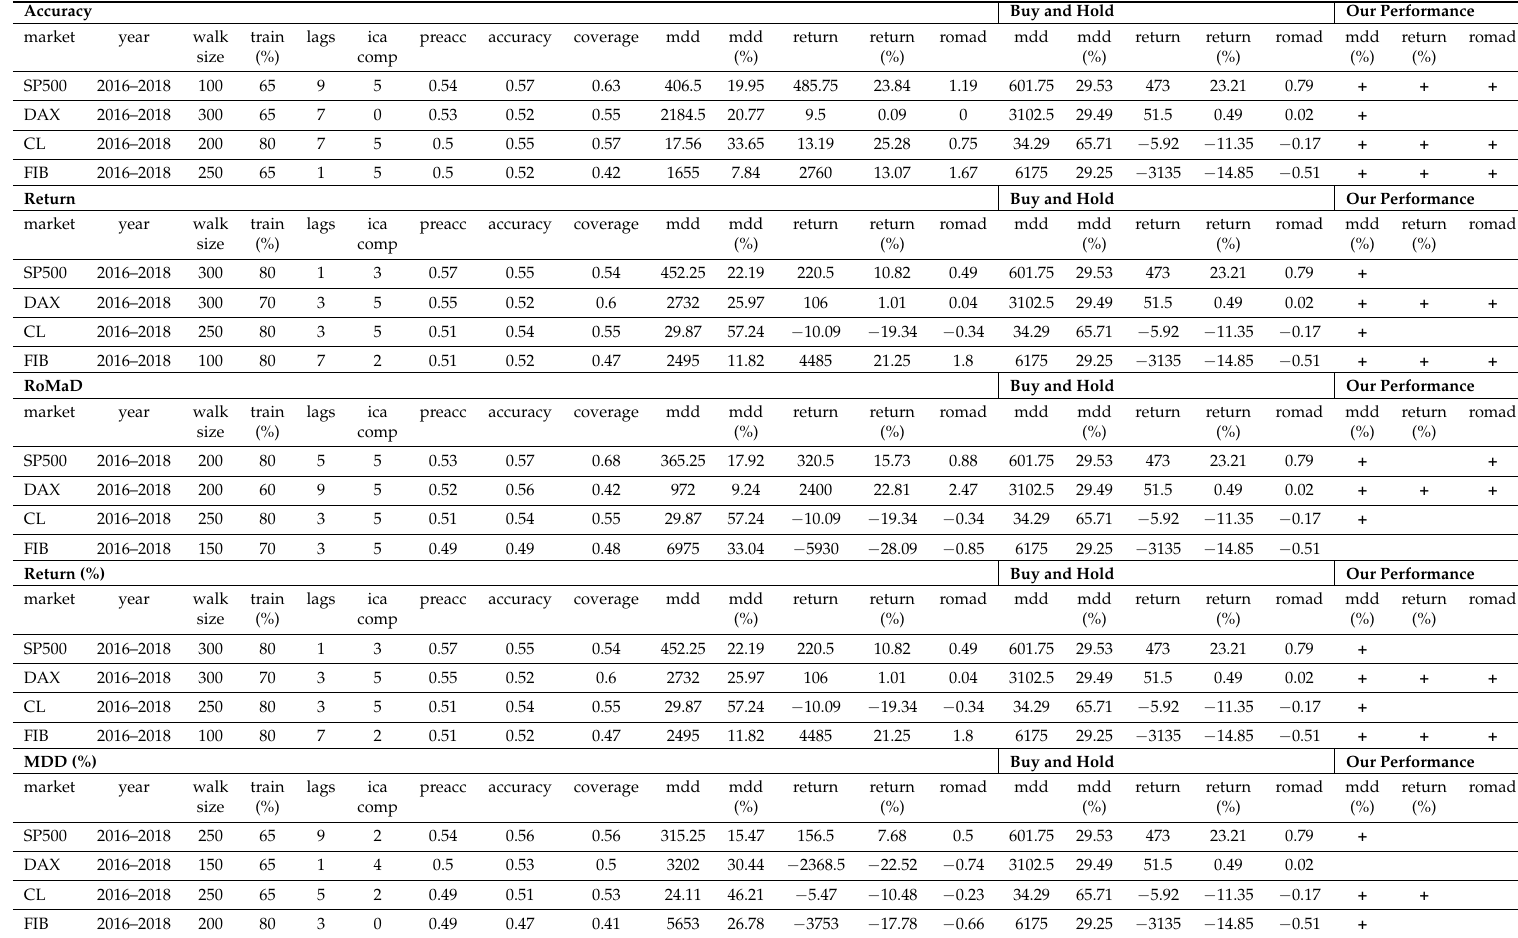
Table 9. Comparison of the proposed approach against the Buy and Hold benchmark by considering different performance metrics in building the proposed self-configurable